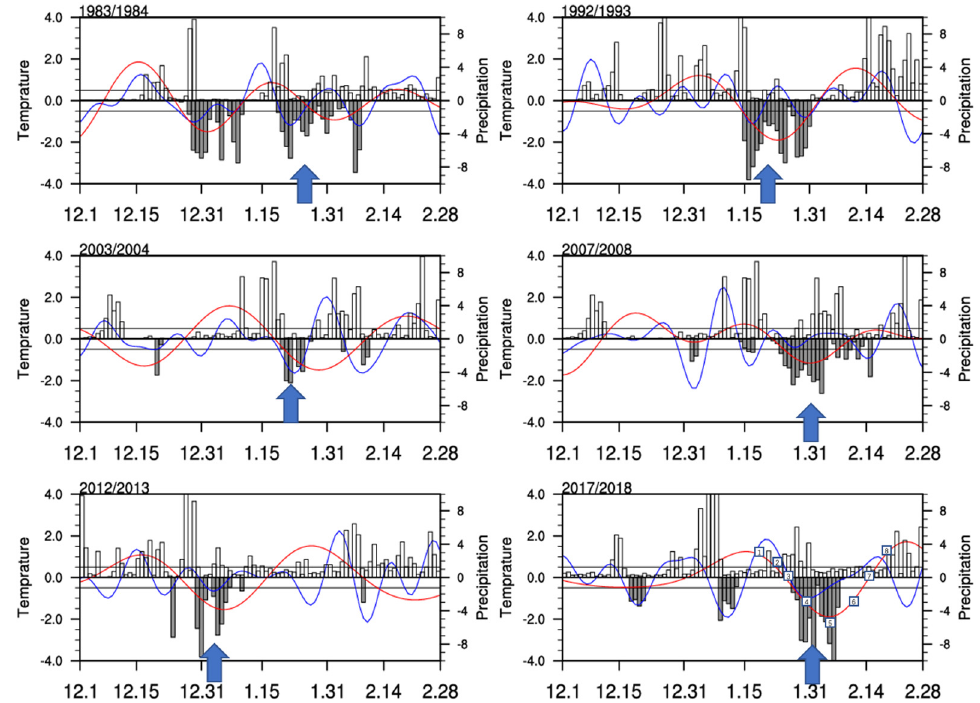
Figure 5. Time series of T min minus thresholds corresponding (black bars) to extreme low-temperature days in southern China for 6 CPEs with filtered series from 10 to 30 d (blue line) and 30 to 60 d (red line) (left y -axis, unit: °C); white bars: precipitation (right y -axis, unit: mm/day); black line: ±0.5 standard deviation; blue arrows: CPEs; numbers 1–8: different phases of intraseasonal oscillations in Figure 5 of 2017/2018 CPE.